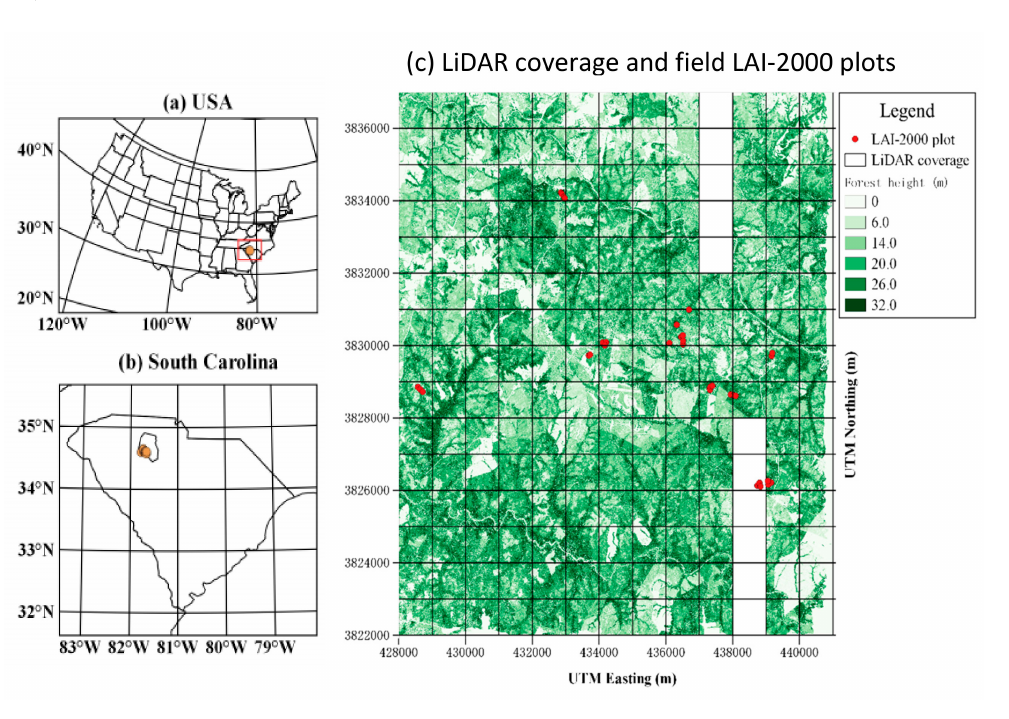
Figure 1. Location of the research area in the USA ( a ) and in South Carolina ( b ), and Light Detection and Ranging (LiDAR) coverage overlaid by forest tree height ( c ), where white grids indicate that LiDAR data are unavailable. The red dots in ( c ) are the leaf area index (LAI)-2000 sampling